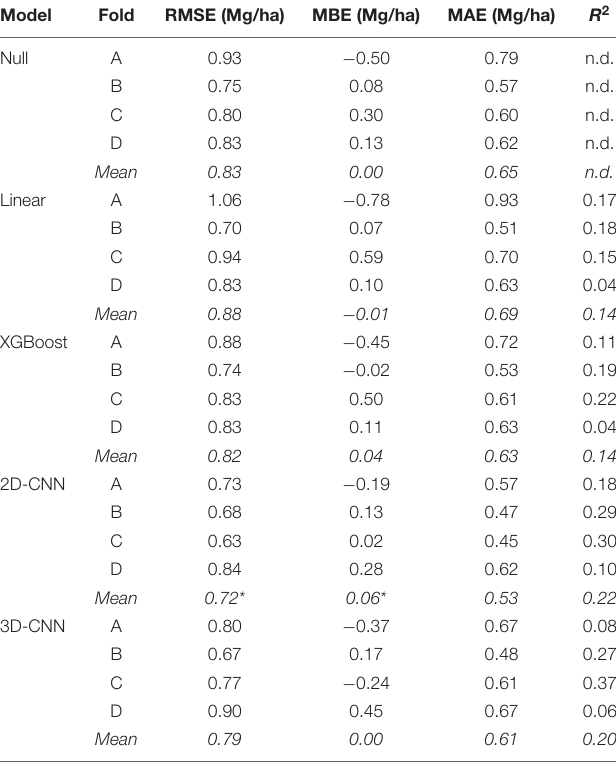
*Indicates significant difference in mean value between 2D-CNN and linear model only (p ≤ 0.05; one-way ANOVA). RMSE, root mean squared error; MBE, mean bias error; MAE, mean absolute error;R 2 , coefficient of determination. n.d., not defined (observed ∼ predicted yield is a vertical line for the null